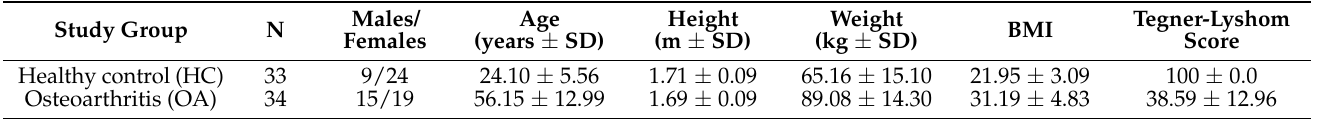
Table 1. Characteristics of the study